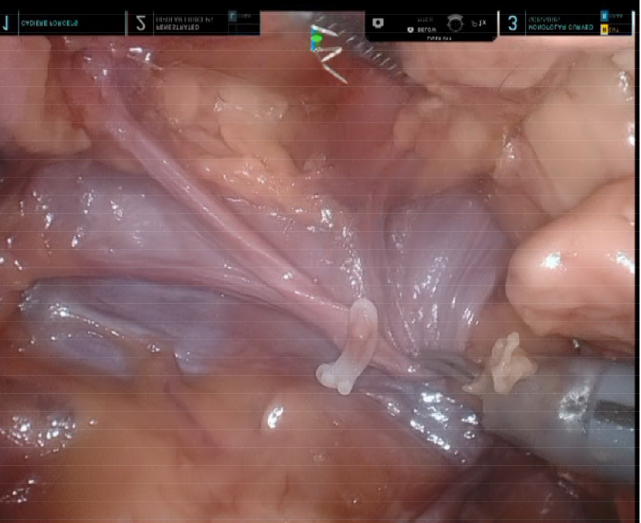
Figure 3. Final view after completion of subxiphoid thymectomy performed by means of the da Vinci ® SP system. The innominate vein underwent complete skeletonization, whereas the thymic vein branch was controlled using Hem-o-Lok